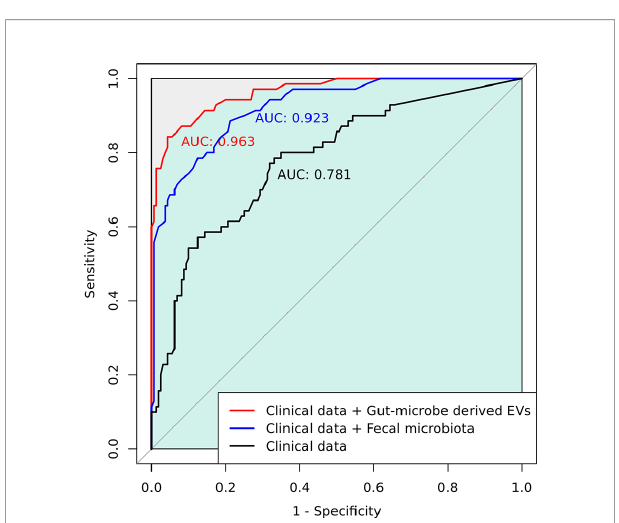
FIGURE 3 | A combined receiver operating characteristic (ROC) analysis using clinical data and gut microbe-derived